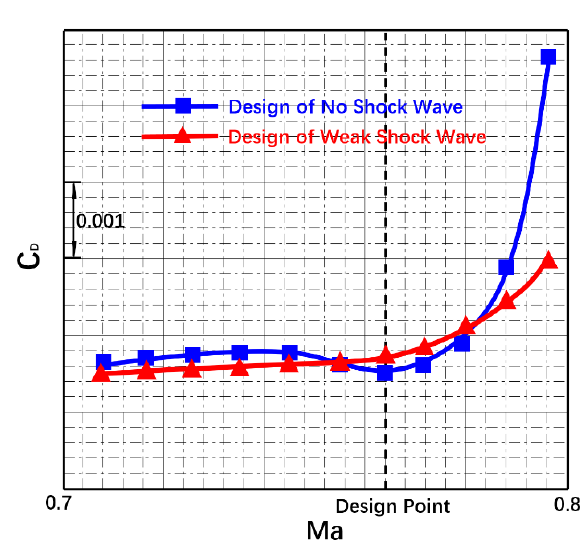
Figure 23. Comparison with and without weak shock wave.